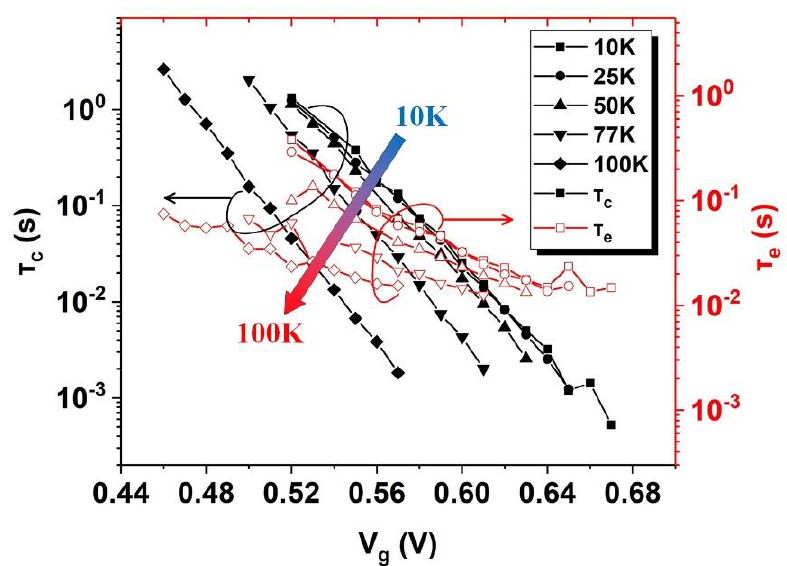
Figure 4. Plots of 𝜏 𝑐 (solid) and 𝜏 𝑒 (open) versus 𝑉 𝑔 at cryogenic temperatures ranging from 10 K Figure 4. Plots of τ c (solid) and τ e (open) versus V g at cryogenic temperatures ranging from 10 K to to 100 K. 100 K.